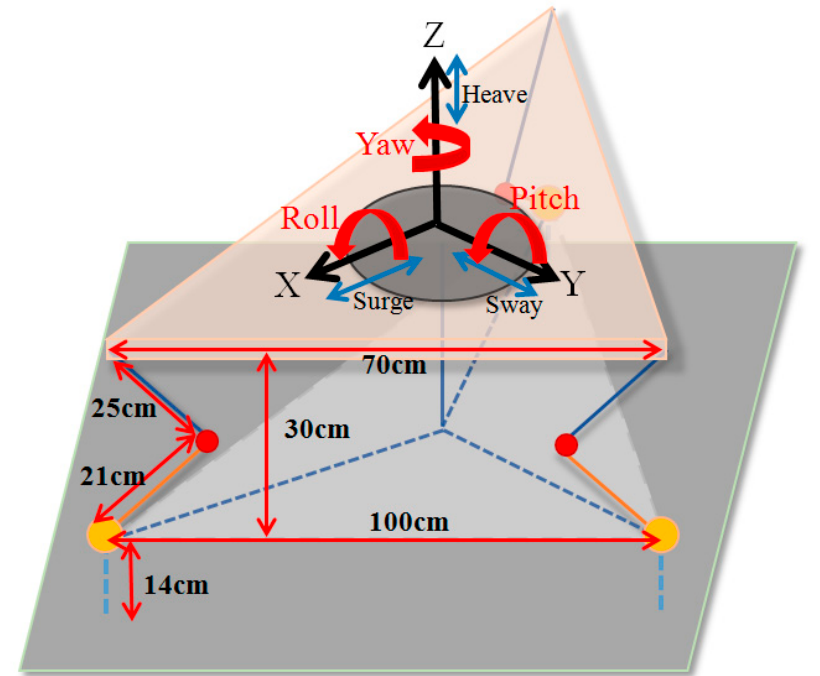
Table 1. The overall specifications.